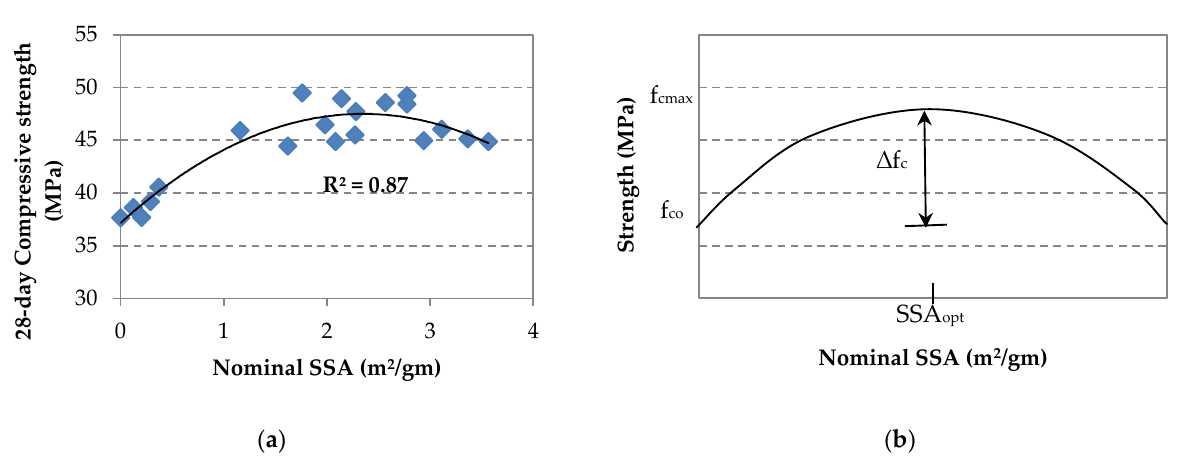
Figure 10. Strength enhancement to nominal SSA relationship: ( a ) compressive strength; ( b ) hypothetical strength behav- ior.